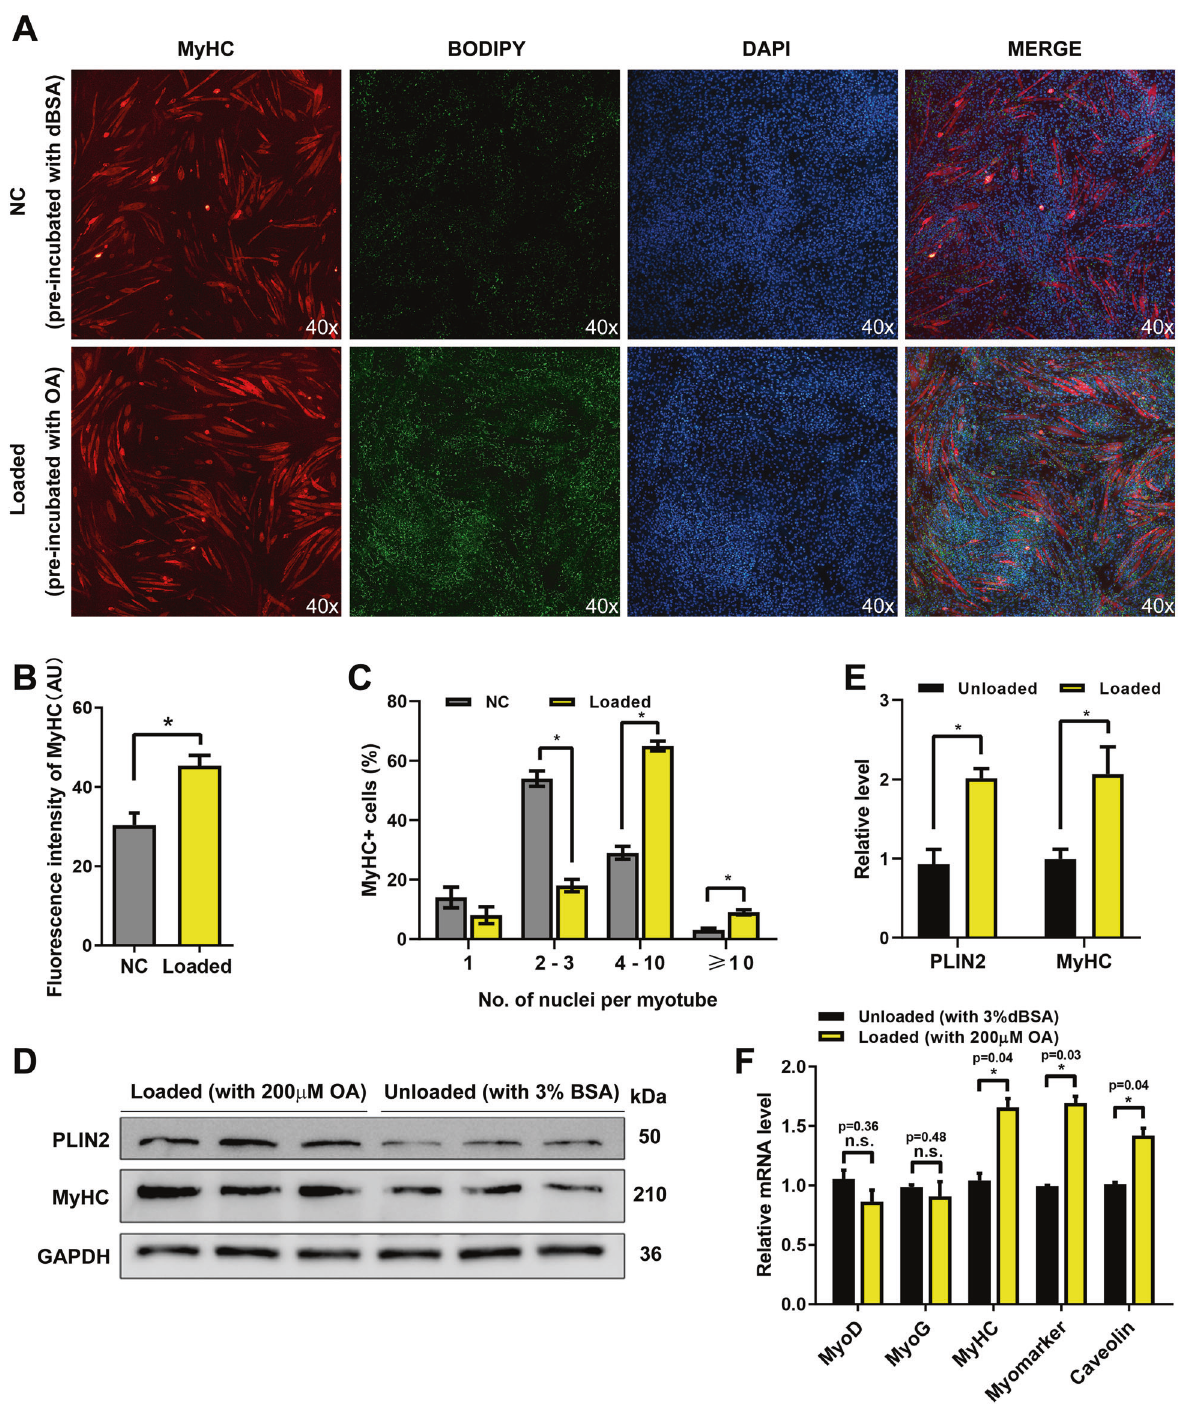
Fig. 1 LDs promote myoblast to form multinucleated myotubes. A The immuno fl uorescence detection of MyHC in the loaded (pre- incubated with the OA medium before differentiation) and unloaded cells (pre-incubated with BSA medium). The LDs were stained by BODIPY (green). The nucleus were stained by DAPI. B The fl uorescence intensity analysis of MyHC. C Fusion rate analysis of A . D PLIN2 and MyHC levels in loaded and unloaded cells after 4 days of differentiation. E Gray value analysis of western blotting. F The mRNA levels of MyoD, MyoG, MyHC, Myomaker, and Caveolin were detected by qPCR in loaded cells and control cells. * p < 0.05; n.s. not signi fi cant. Results are from three technical repeats ( N = 3) for a representative of three biological repeats ( N = 3). fi bers, and actin cap stress fi bers) in C2C12 cells (Fig. 5A). We then LDs surface. Firstly, we con fi rmed the localization of ACTN3 on LDs detected the level of LD-ACTN3 during actin-cytoskeleton surface through laser confocal microscope and western blot. The remodeling. After treating the cells with cytochalasin D for 2 h, results showed ACTN3 co-localized to whole micro fi lament the cells were washed by phosphate buffer saline (PBS) twice and (including ventral stress fi bers, back stress fi bers, peripheral stress Cell Death and Disease (2021)